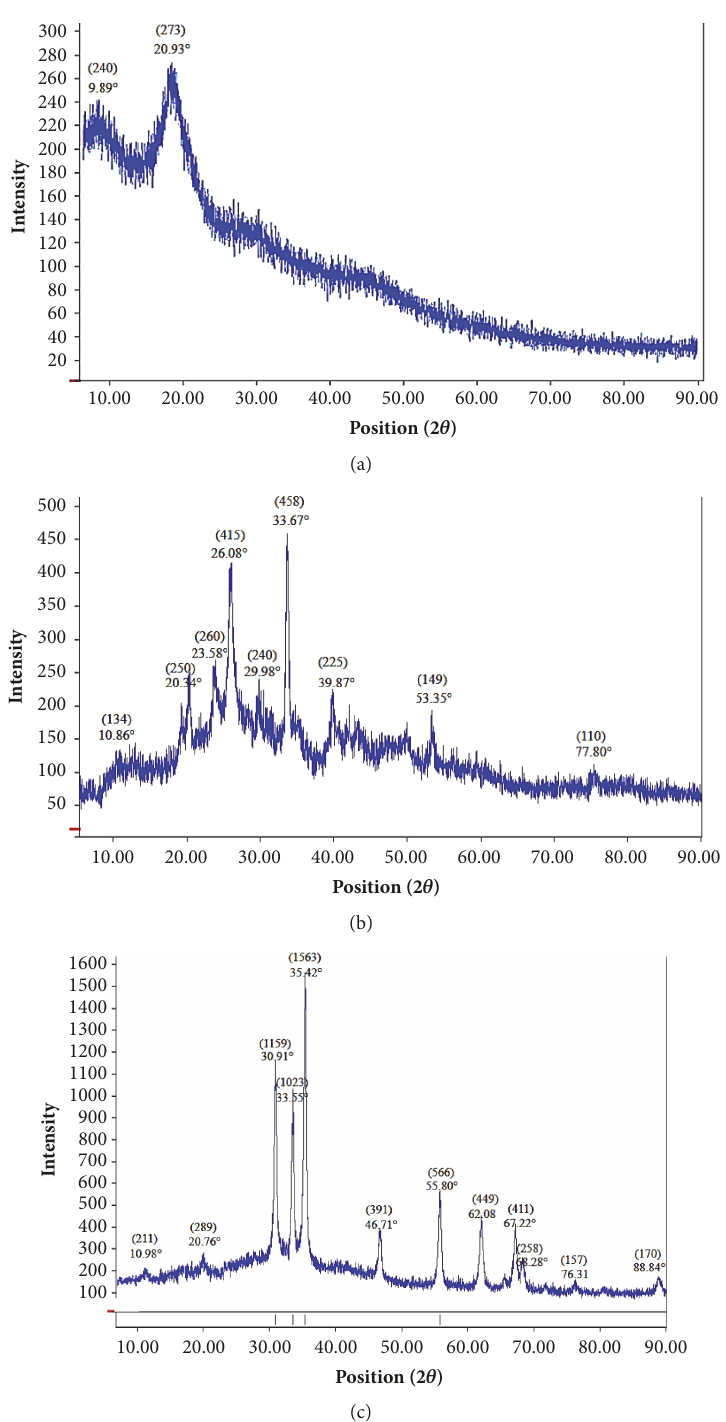
Figure 3: X-ray diffraction (XRD) patterns of chitosan (a), Ch-CuO NPs (b), and Ch-ZnO NPs (c).